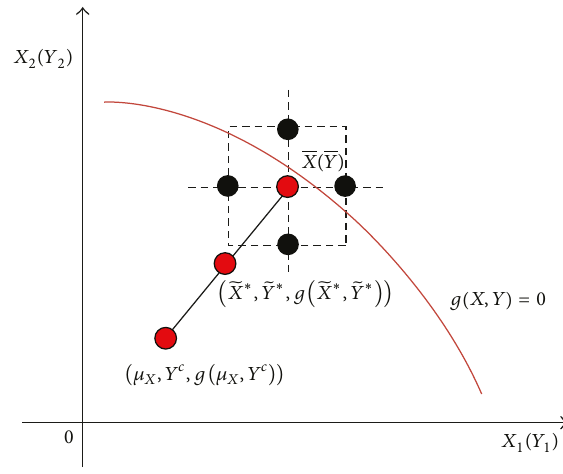
Figure 4: Obtaining a new sample centre point.